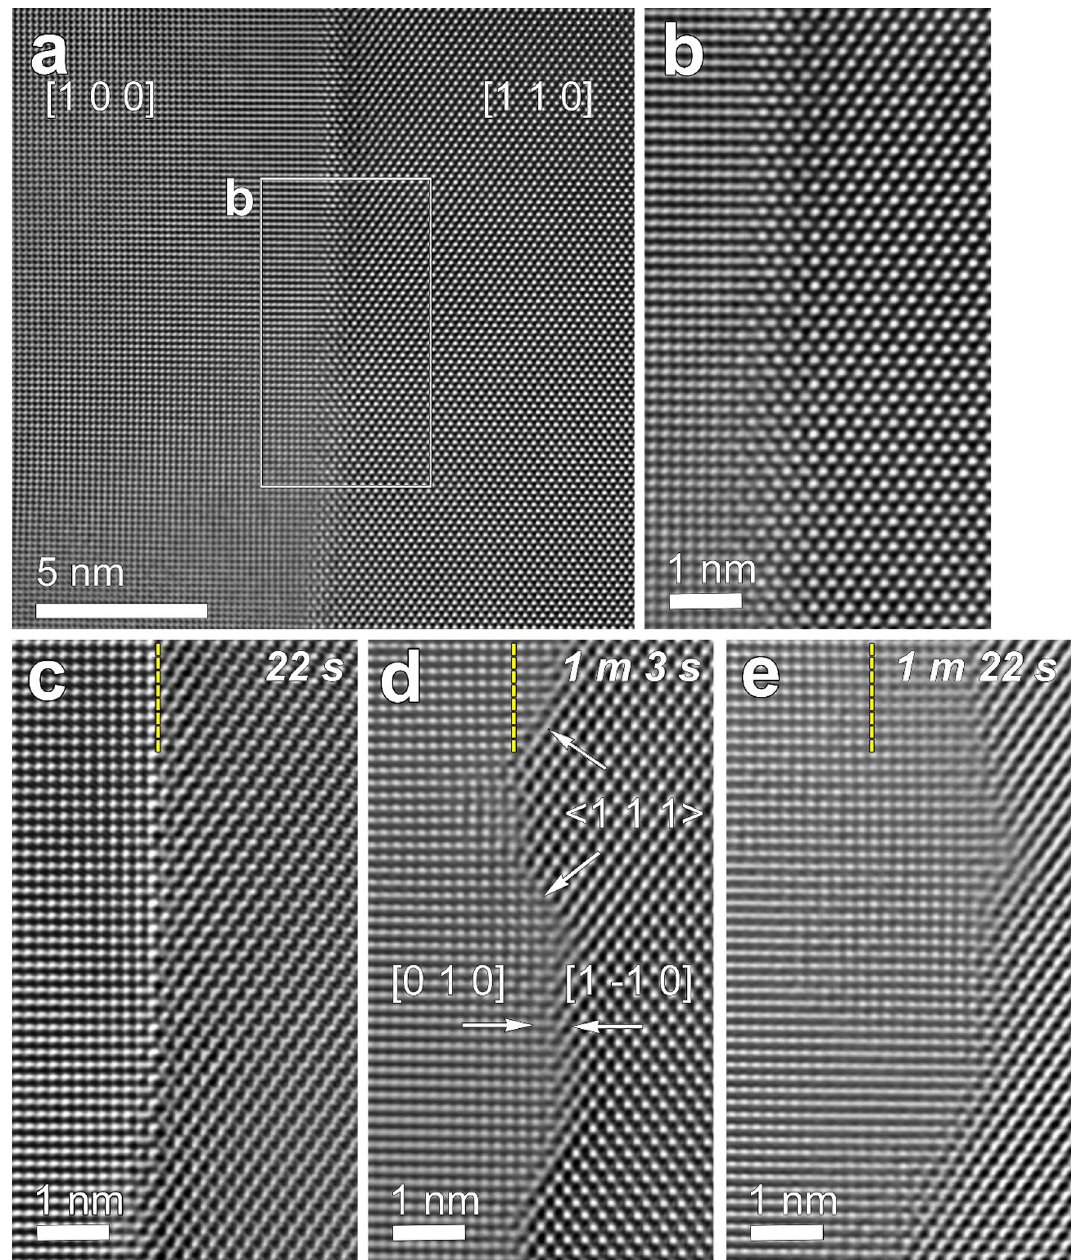
Figure 2. Sequential HRTEM images showing microstructural evolution of a GB region under beam irradiation with a beam diameter of 50 nm corresponding to a current density of ~ 204 A cm –2 . The region shown in this figure was included in the irradiation diameter of 50 nm. ( a ) An initially rough GB. For reference, the irradiation diameter and corresponding current density are specified side-by-side. ( b – e ) Time evolution of the boxed region in ( a ) during irradiation obtained by in situ observation. The elapsed irradiation time in the condition is labeled at the upper right corner of each figure. (Minutes and seconds are abbreviated as m and s, respectively.) ( c – e ) The GB reveals atomically sharp (0 1 0)//(1 –1 0) and {1 1 1} facets and its migration into [1 1 0]. See text for details of the plane notations. The vertical yellow dashed lines in the figures indicate the initial position of the GB shown in ( c